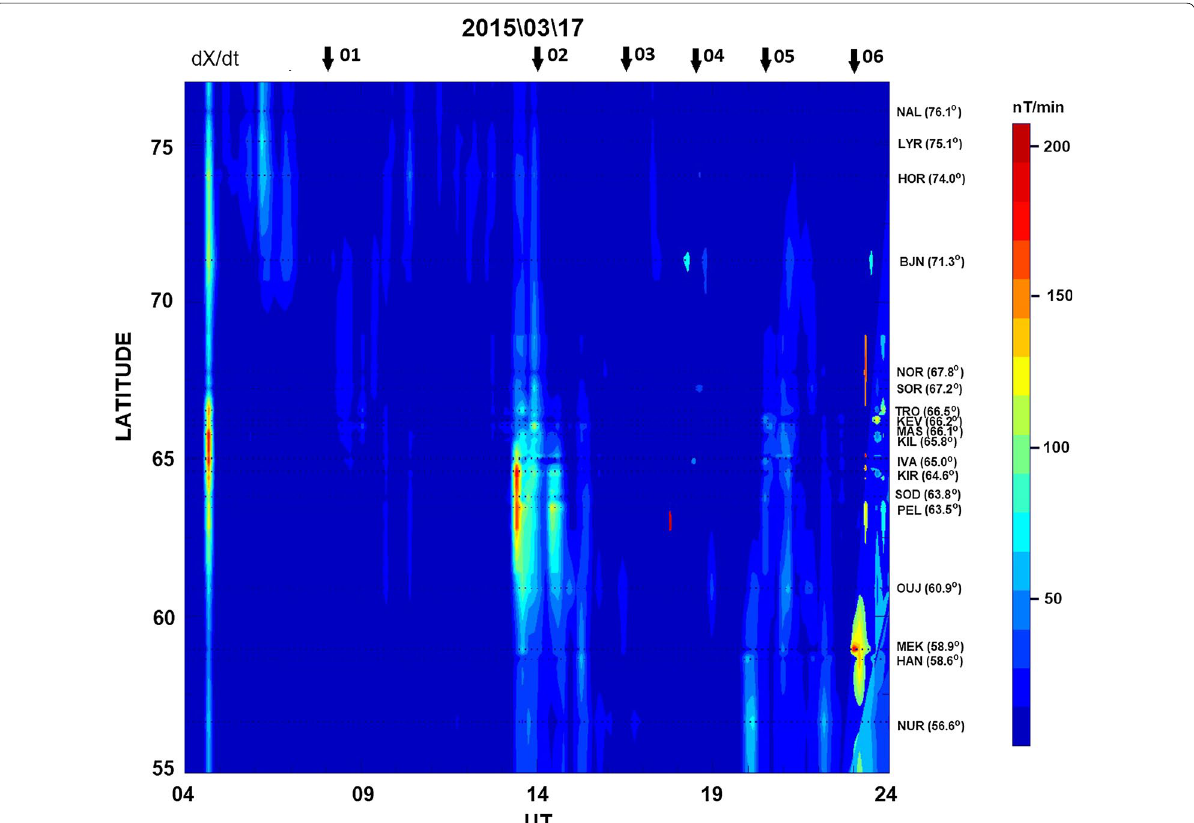
Fig. 7 Magnetic keogram showing the dynamics of latitudinal distribution of magnetic variability magnitude |d X /d t | along the IMAGE profile during the storm main phase 04–24 UT. Color coding is saturated to reveal signatures of weaker magnetic field variability. Codes and geomagnetic latitudes of selected IMAGE stations are indicated near the right-hand Y -axis. Arrows mark substorm #1–6